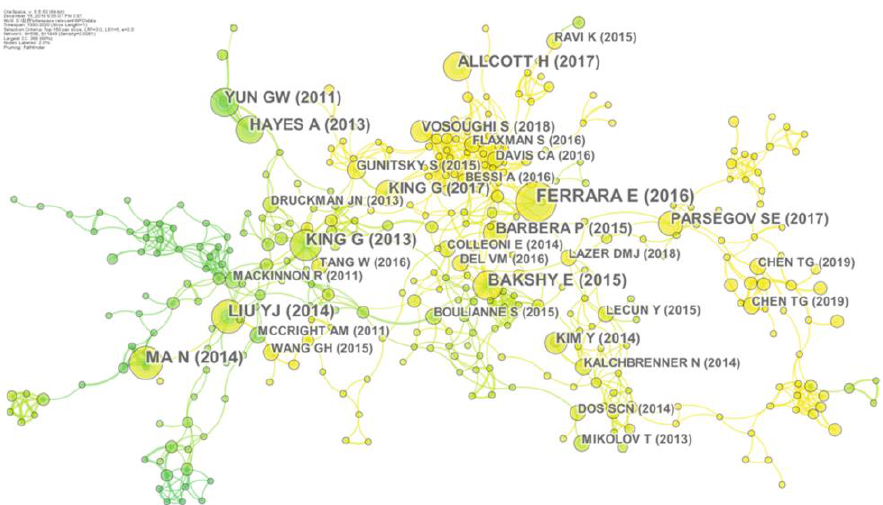
Figure 9. Authorship analysis of references in NPO studies.